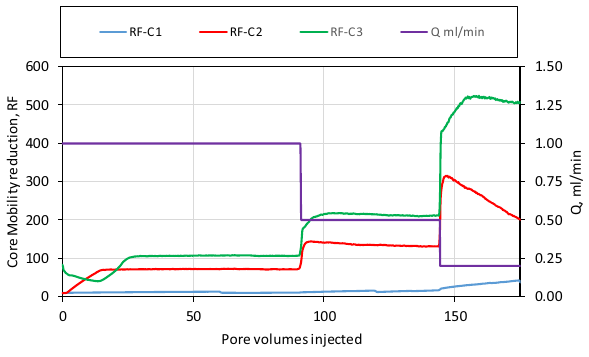
Fig. 8 Experiment 4, 1000 ppm A10 in SSW in Bentheimer. RF pm as a function of pore volumes injected. T1 = 20 °C, T2 = 60 °C and T3 = 80 °C. The volumetric injection rate is 1 ml/min from 0 to 91 pore volumes, and 0.5 ml/min from 91–147 PV and 0.2 ml/min from 147–176 pore volumes